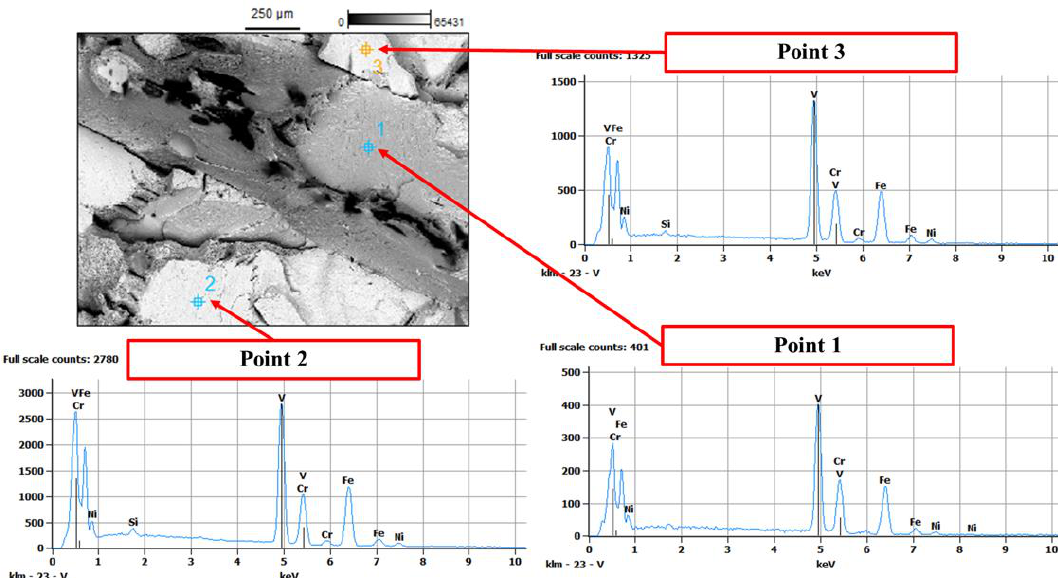
Figure 17. EDS of the specimen tested at Δσ = 170 MPa and failed at 1,148,109 cycles (specimen 3). The arrows indicate the analyzed points. Table 9. Summary of fracture modes.